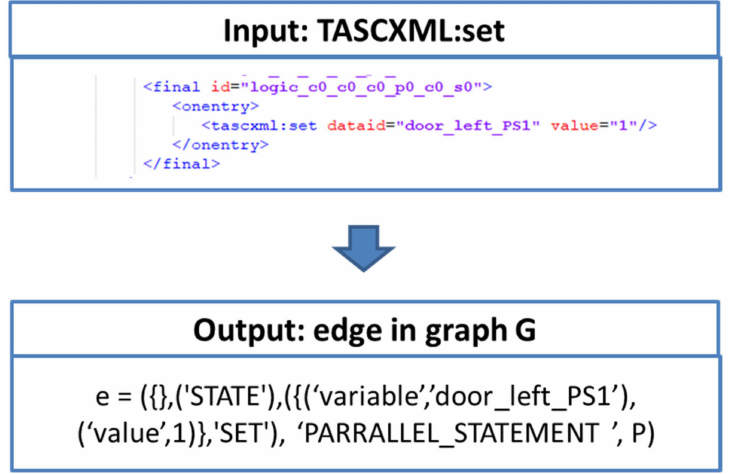
Figure 10. Example for mapping the TASCXML: set to a graph